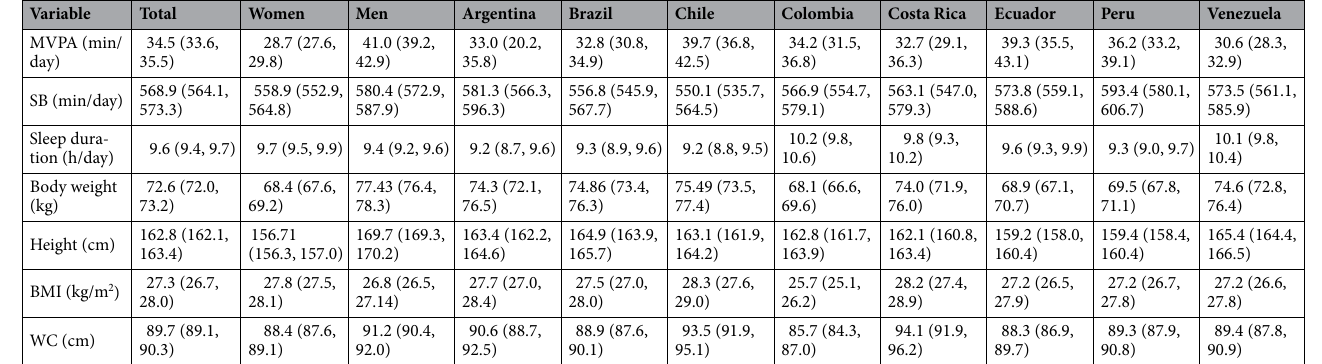
Table 2. Descriptive characteristic (mean and 95% CI) of participants by sex and country. 95%CI, 95% confidence interval; MVPA, moderate-to-vigorous physical activity; SB, sedentary behavior; BMI, body mass index; WC, waist circumference.